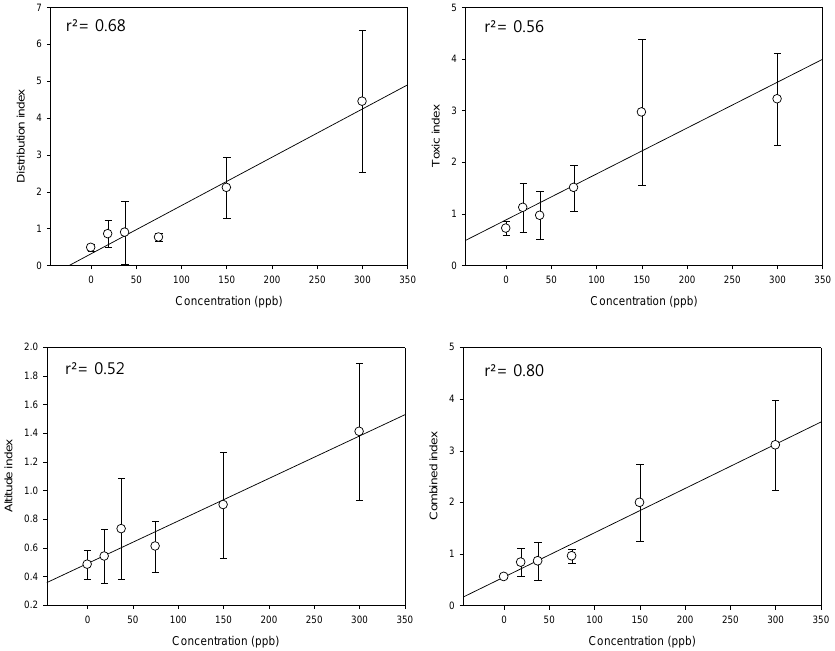
Figure 4. Linear regressions between representing value (average) of index and copper concentration. The line is regression line and r 2 is correlation coe ffi cient